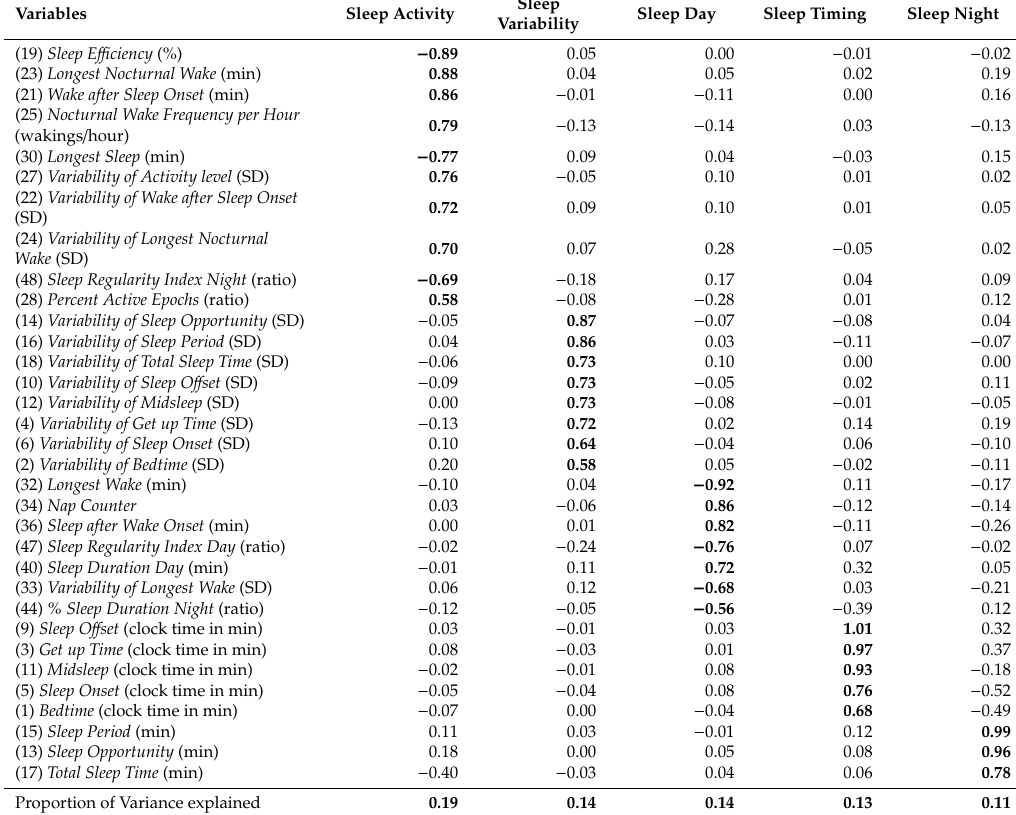
Table 2. Single sleep variables and PCA solution with oblique rotation ( promax rotation). The numbers in parentheses link the single sleep variables to their explanation in Table 1. Values in bold indicate the strongest loading. A total of 14 variables were excluded due to their low loading ( < 0.512) on any of the sleep composites. These were (7) Sleep Latency (min), (8) Variability of Sleep Latency (SD), (20) Variability of Sleep E ffi ciency, (26) Variability of Nocturnal Wake Frequency per Hour (SD), (29) Variability Percent Active Epochs (SD), (31) Variability of Longest Sleep (SD), (35) Variability Nap counter (SD), (37) Variability Sleep after Wake Onset (SD), (39) Variability of Sleep Duration 24 h (SD), (41) Variability Sleep